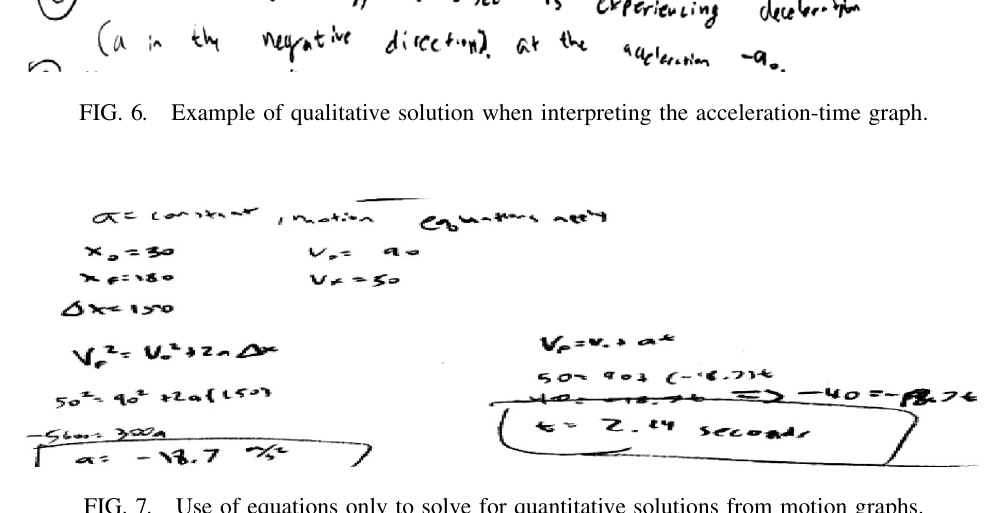
FIG. 7. Use of equations only to solve for quantitative solutions from motion